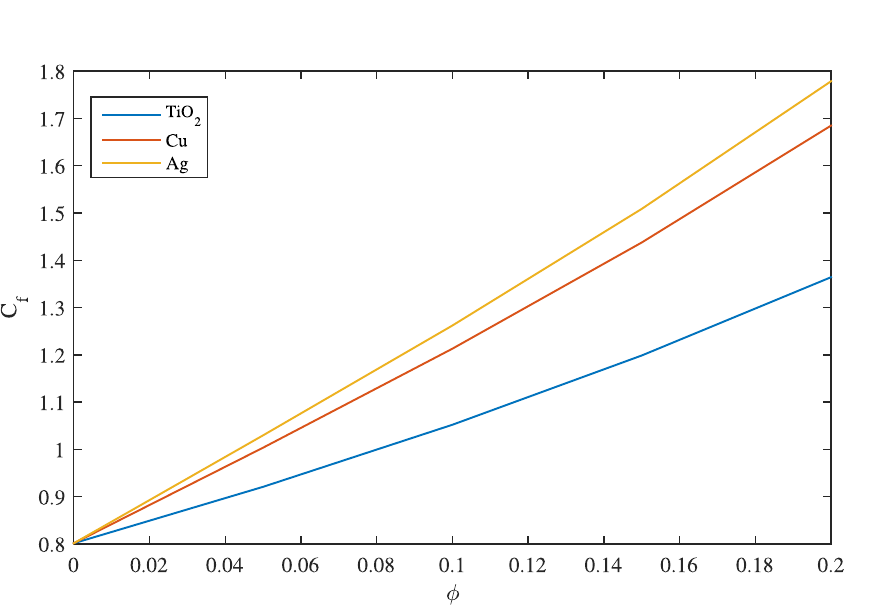
Figure 21. Effects of variation of nanoparticle volume fraction φ on temperature profile, when c 0.1 , β 0.2 N 0.2 , and Pr ζ rd = = =